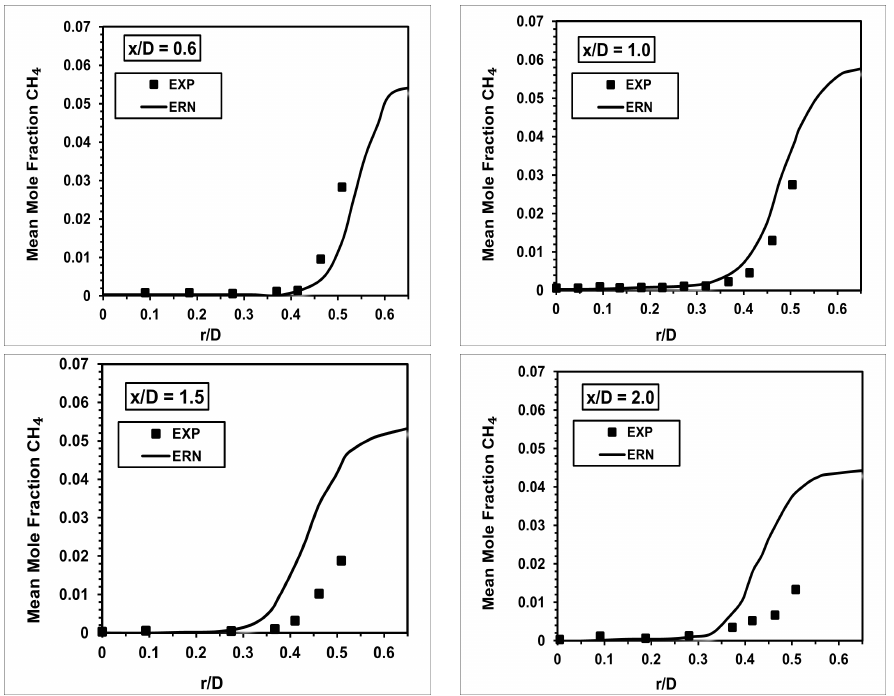
Figure 8. The computed mean CH 4 mole fraction is compared to the experimental measurements at axial locations x / D : 0.1, 0.3, 0.6, 1, 1.5, and 2.